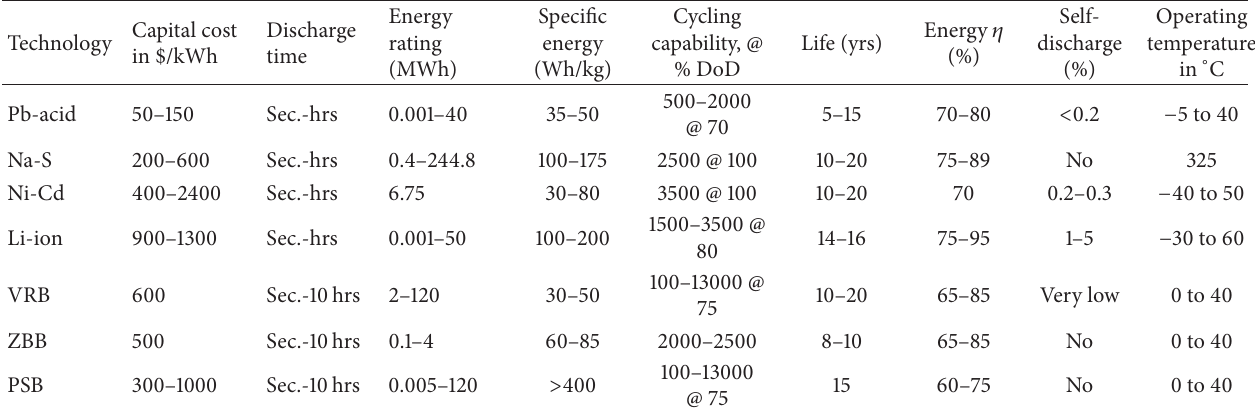
Table 2: Properties of batteries [8, 24, 25].